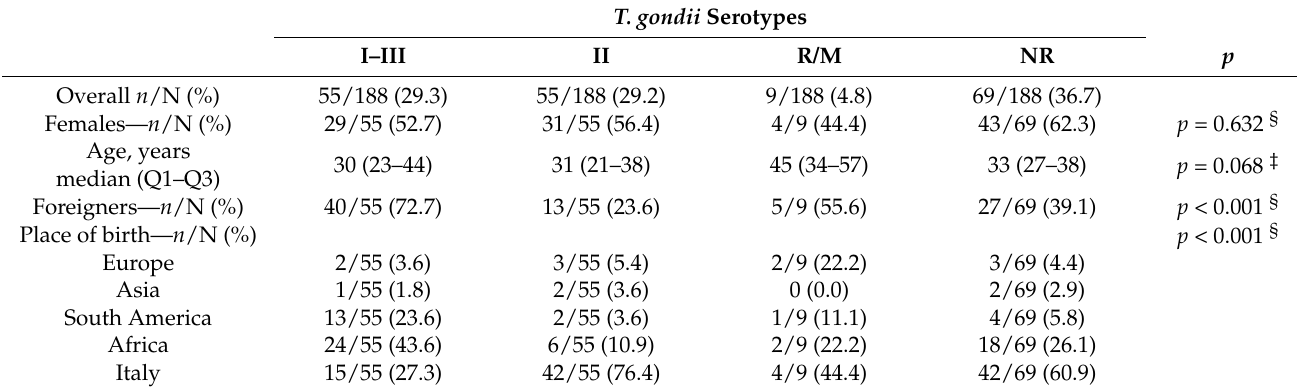
Table 2. Main patient characteristics according to T. gondii serotype.